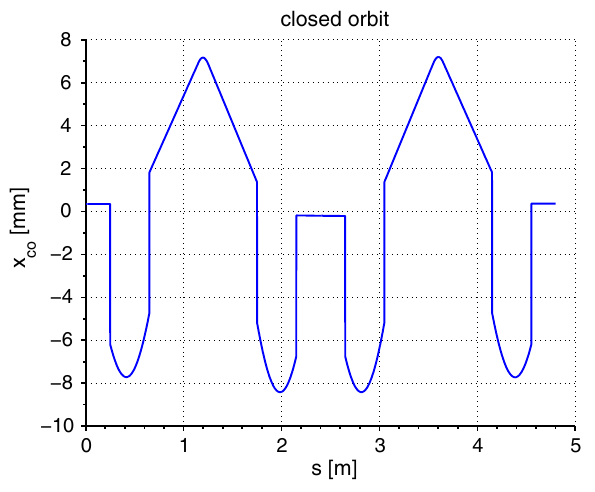
FIG. 13. Closed orbit of TTX introduced by the dipole fringe field effect. The fringe field effect is assumed equal to the dipole magnetic gap of 25.4